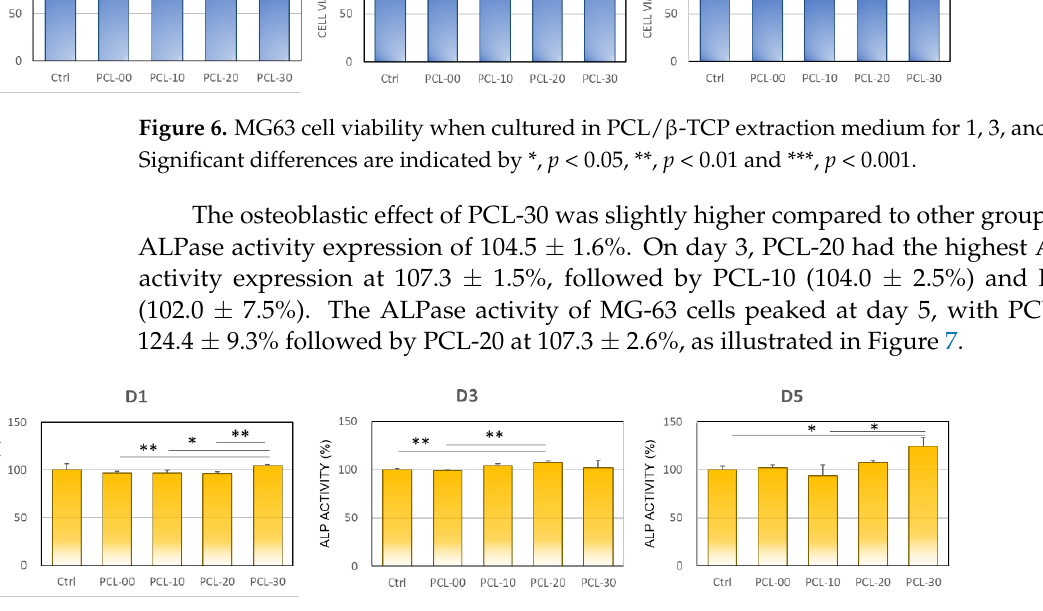
Figure 7. Alkaline phosphatase activity of MG63 cell on PCL/ β -TCP extraction medium for 1, 3, and 5 days. Significant differences are indicated by *, p < 0.05 and **, p < 0.01.